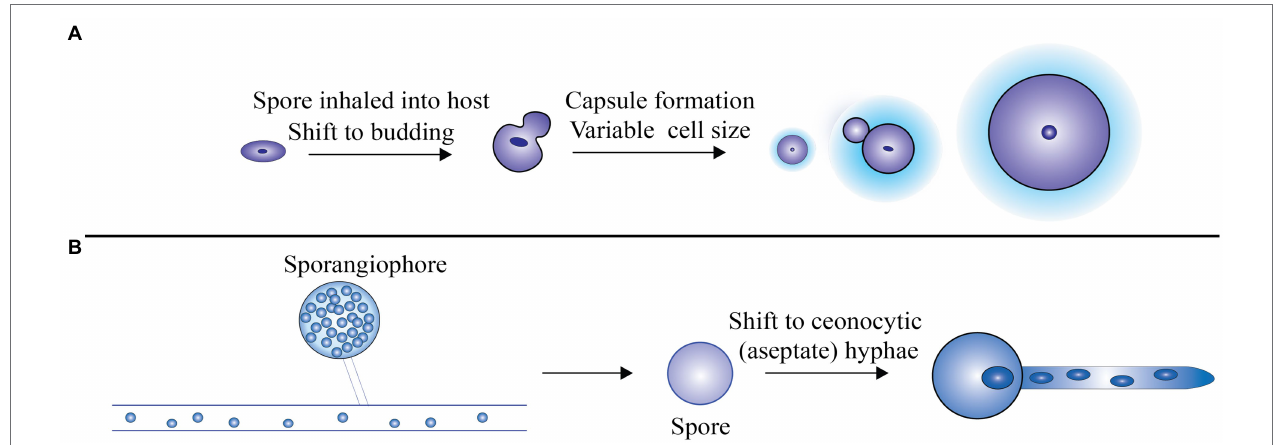
FIGURE 1 | (A) The spores revert back to the budding mode of replication after being inhaled by the host. For protecting the cells against stress and unfavorable environment, a thick polysaccharide capsule is formed and also the formation of large cells that are immune to phagocytosis, (B) Rhizopus oryzae grows as coenocytic (aseptate) hyphae, which produce few septa in the host. Adapted from Min et al.